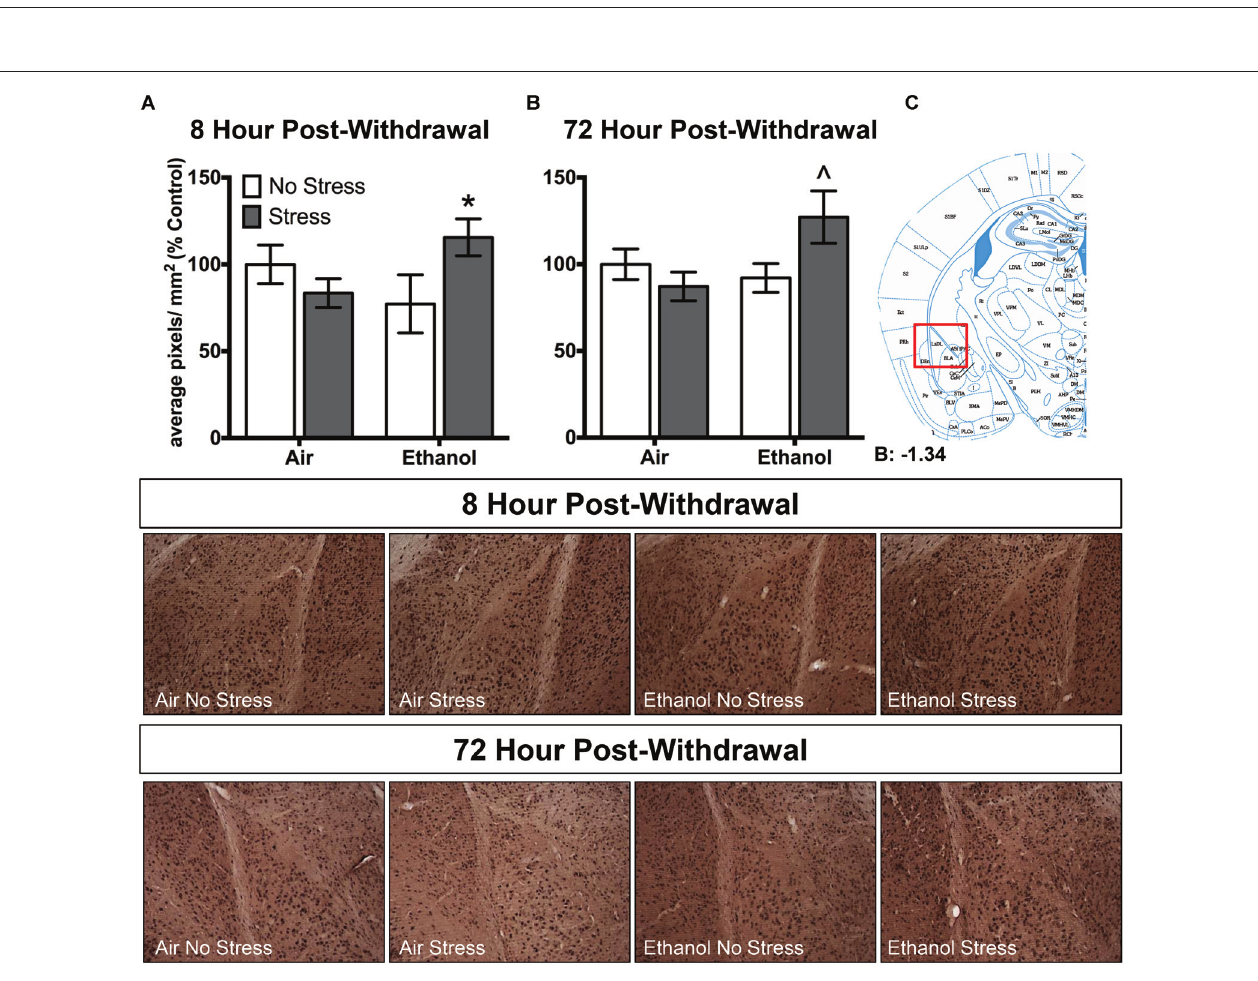
FIGURE 3 | Effects of CIE or air exposure on 3 α ,5 α -THP immunoreactivity in the lateral amygdala following (A) 8 h or (B) 72 h post-withdrawal in non-stressed (clear bars) or stressed mice (gray bars) . Data depicted are mean positive pixels/mm 2 expressed as percent control ± SEM. (C) Red box indicates coordinates relative to bregma depicted in photomicrographs. Representative photomicrographs (10x) of 3 α ,5 α -THP immunoreactivity 72 h post-withdrawal following CIE and/or stress exposure. ∗ p < 0.05 compared to Ethanol-No Stress group; ∧ p < 0.05 compared to Ethanol-No Stress and Air-Stress group.